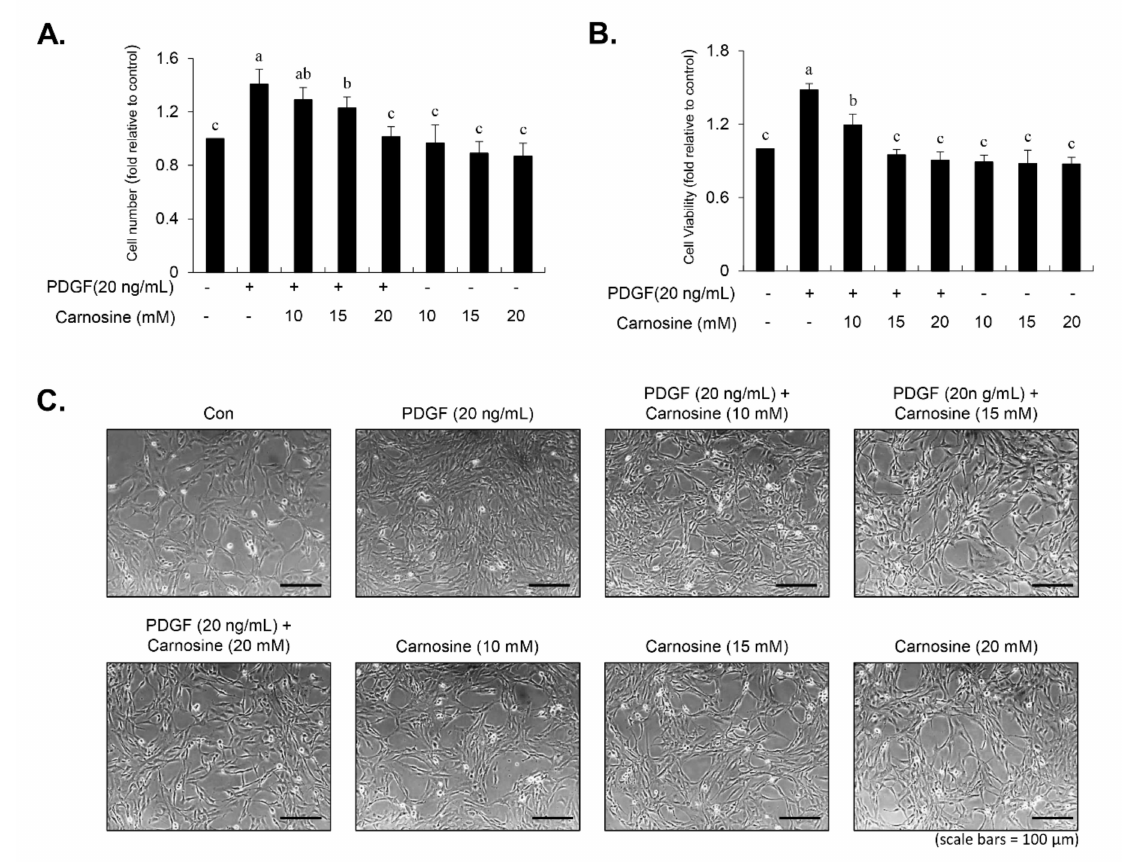
Figure 1. Carnosine inhibited the proliferation of platelet-derived growth factor (PDGF)-induced vascular smooth muscle cells (VSMCs). After 24-h serum starvation, VSMCs were treated with indicated carnosine concentrationsfor45min,andthenstimulatedwithorwithoutPDGF(20ng / mL)for24h. ( A )Cellproliferation wasanalyzedbycellcounting. ( B )Basedonthe3-(4,5-dimethylthiazol-2-yl)-2,5-diphenyltetrazoliumbromide (MTT) assay, cell viability was measured. ( C ) Morphologic changes in PDGF-treated VSMCs when treated with the indicated concentrations of carnosine were photographed. All data are expressed as the mean ± SE of three experiments. The different letters indicate significant differences between the groups ( p <